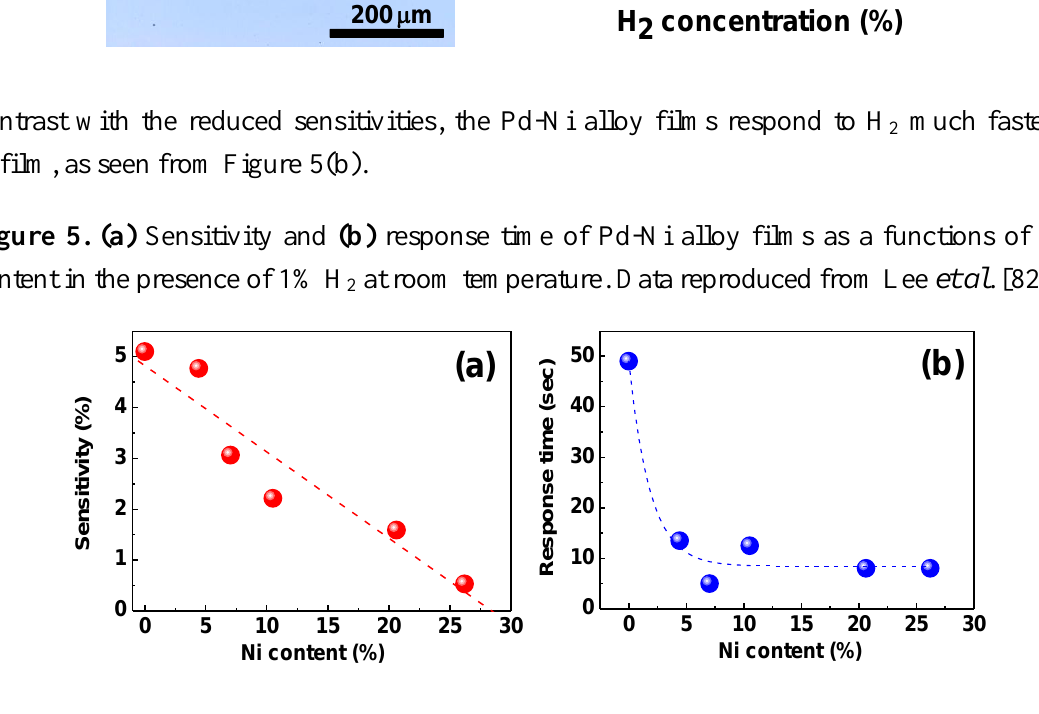
. (b) Sensitivities of a pure Pd film and Pd-Ni 2 concentration at room temperature. 2